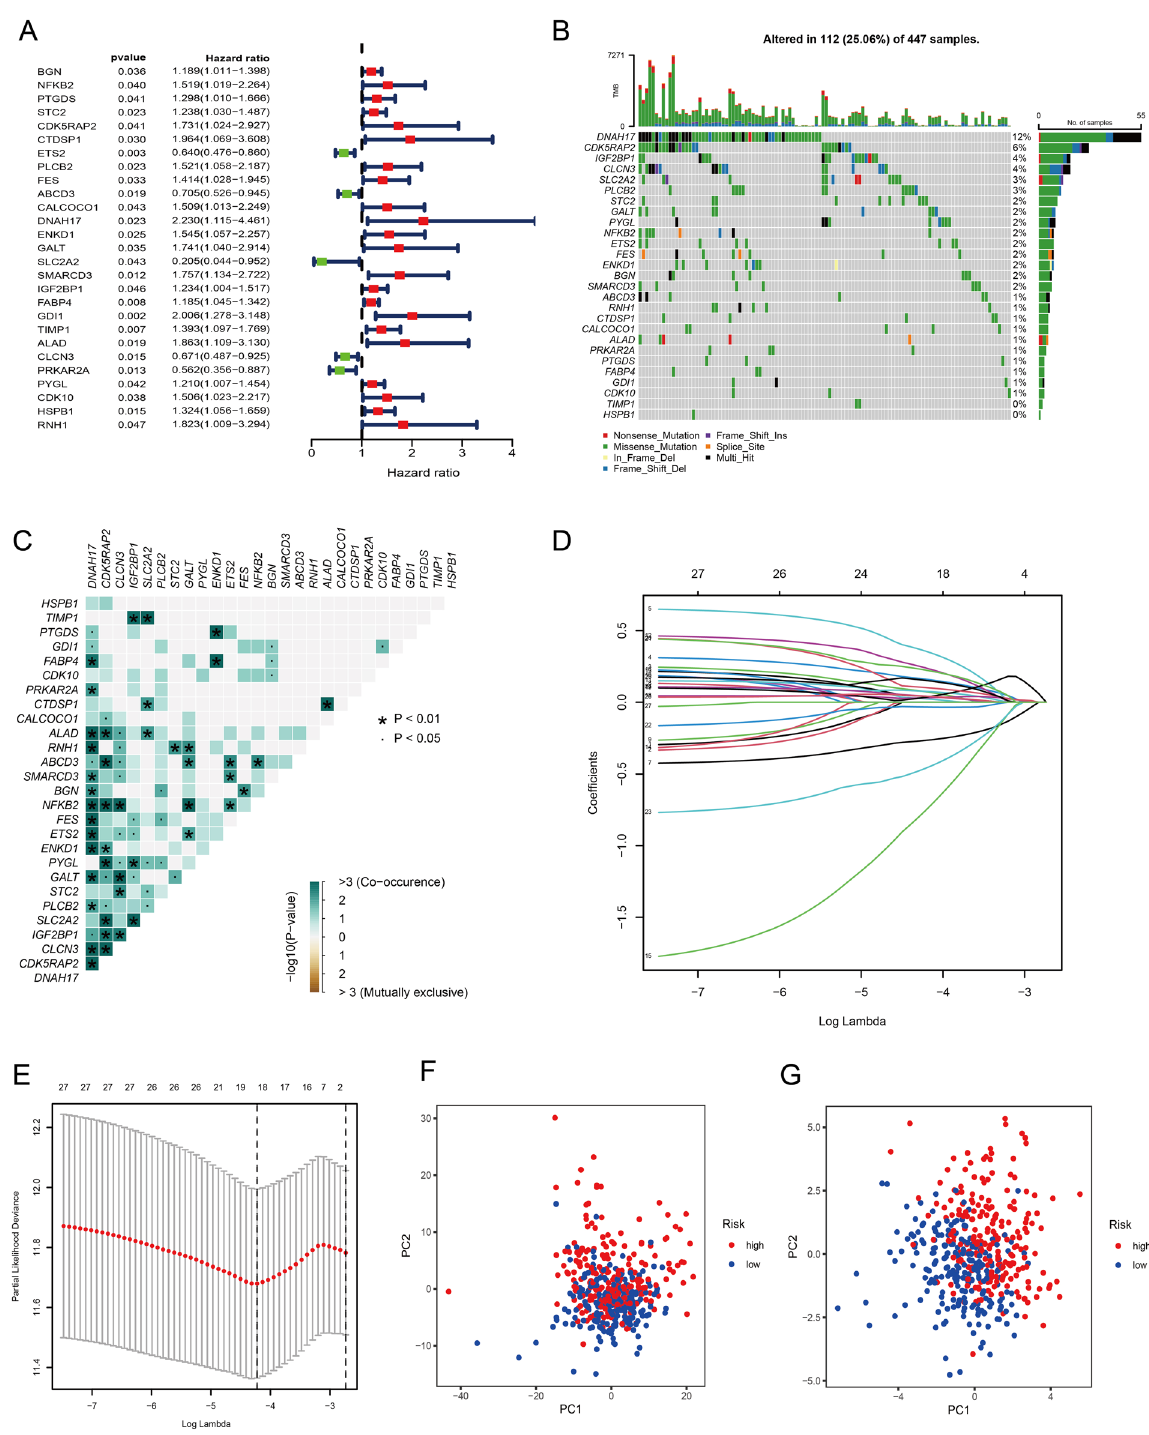
Figure 2. Identification of prognostic genes. ( A ) Univariate Cox regression analysis of butyrate metabolism- related genes. When the hazard ratio of a gene is > 1, it indicates that the gene is a risk factor for the corresponding tumor, and vice versa. ( B ) Gene mutations in CRC patients. ( C ) Correlation of mutations in 27 butyrate metabolism-related genes. Brown color indicates negative correlation, and blue color indicates positive correlation. ( D ) LASSO coefficient spectrum of 27 butyrate metabolism-related genes. ( E ) Cross-validation of adjustment parameter selection in a proportional hazards model. ( F ) PCA based on all butyrate metabolism- related genes. ( G ) PCA based on butyrate metabolism-related model genes. The red group represents high-risk patients, and the blue group represents low-risk